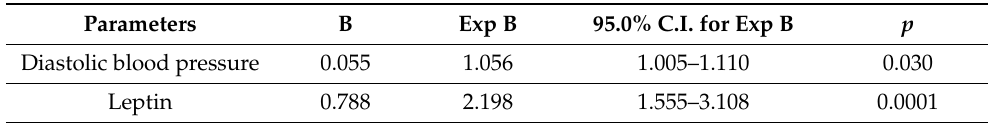
Table 5. Results of a step-by-step regression analysis of the association of adipokines/cytokines with the presence of AO against a background of hyper-LDL-C in men aged 25–44 years.